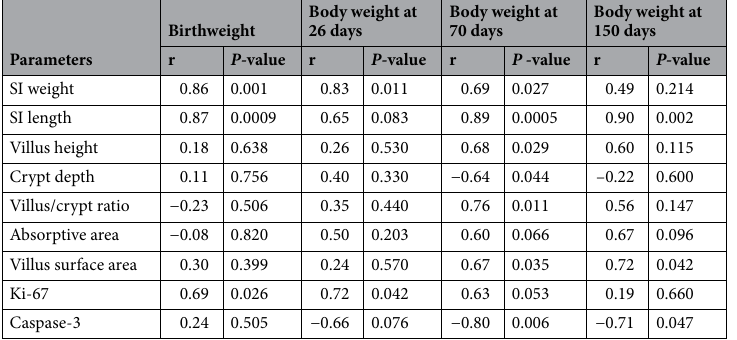
Table 3. Correlations between small intestine morphofunctional parameters and body weight at birth, 26 days, 70 days, and 150 days of age.